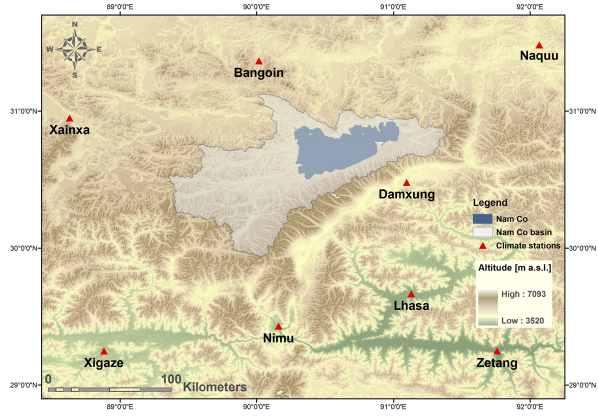
Fig. 1. Location of climate stations surrounding the Nam Co